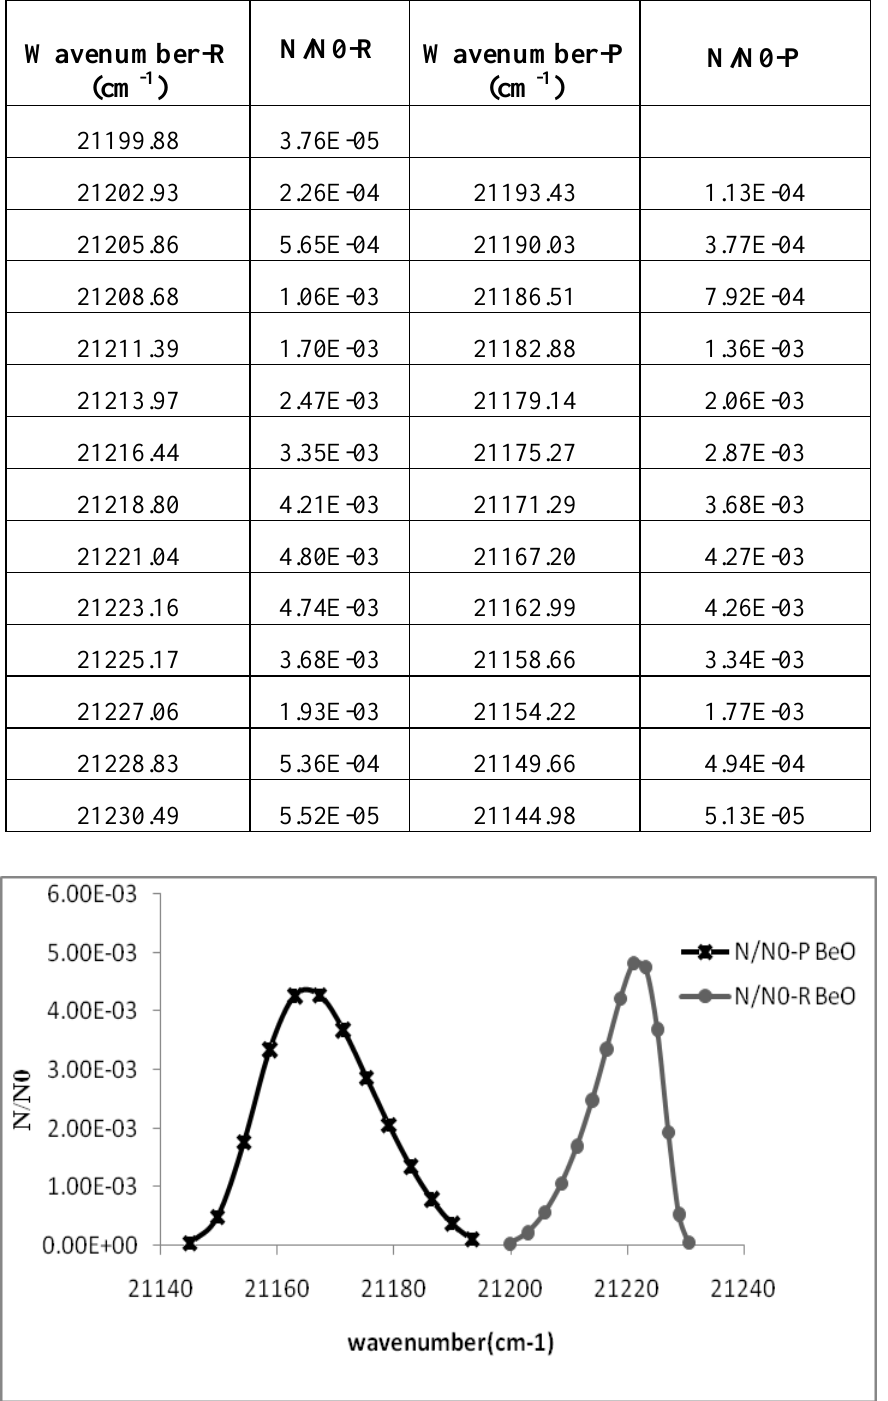
Fig.2: Relative population of B 1 Σ + - X 1 Σ + as a function of wavenumber for BeO molecule